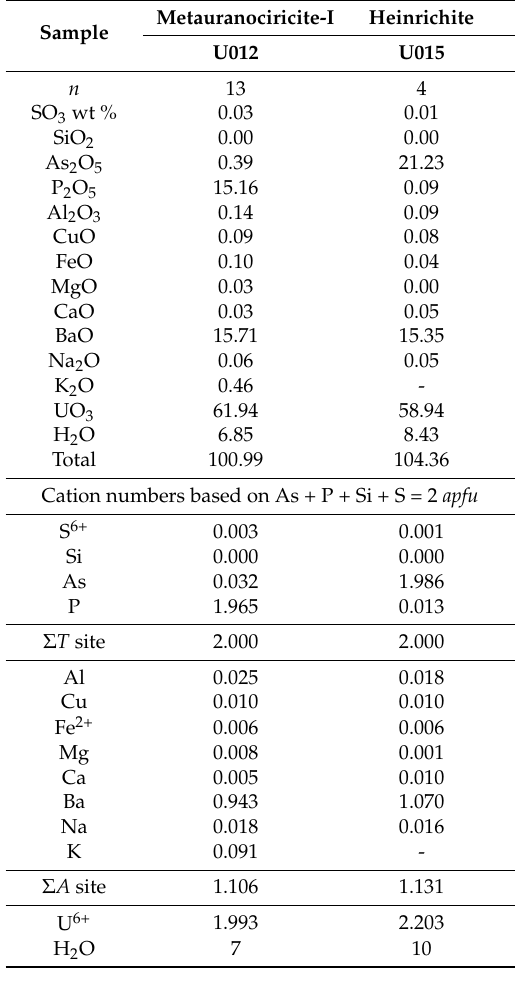
Table 7. Chemical composition of metauranocircite-I and heinrichite.